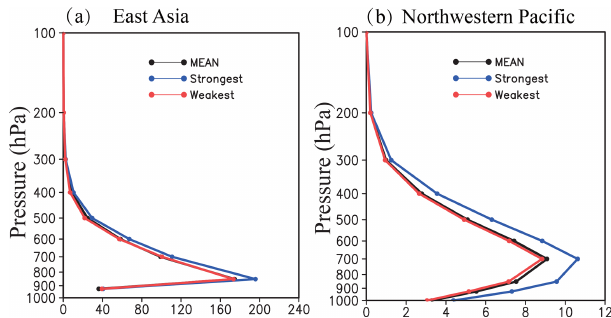
Figure 5. Simulated vertical profile of the MAM dust concentra- tion (µgkg − 1 ) from the model for the mean, strongest, and weak- est years (a) over the East Asian dust source area and (b) over the northwestern